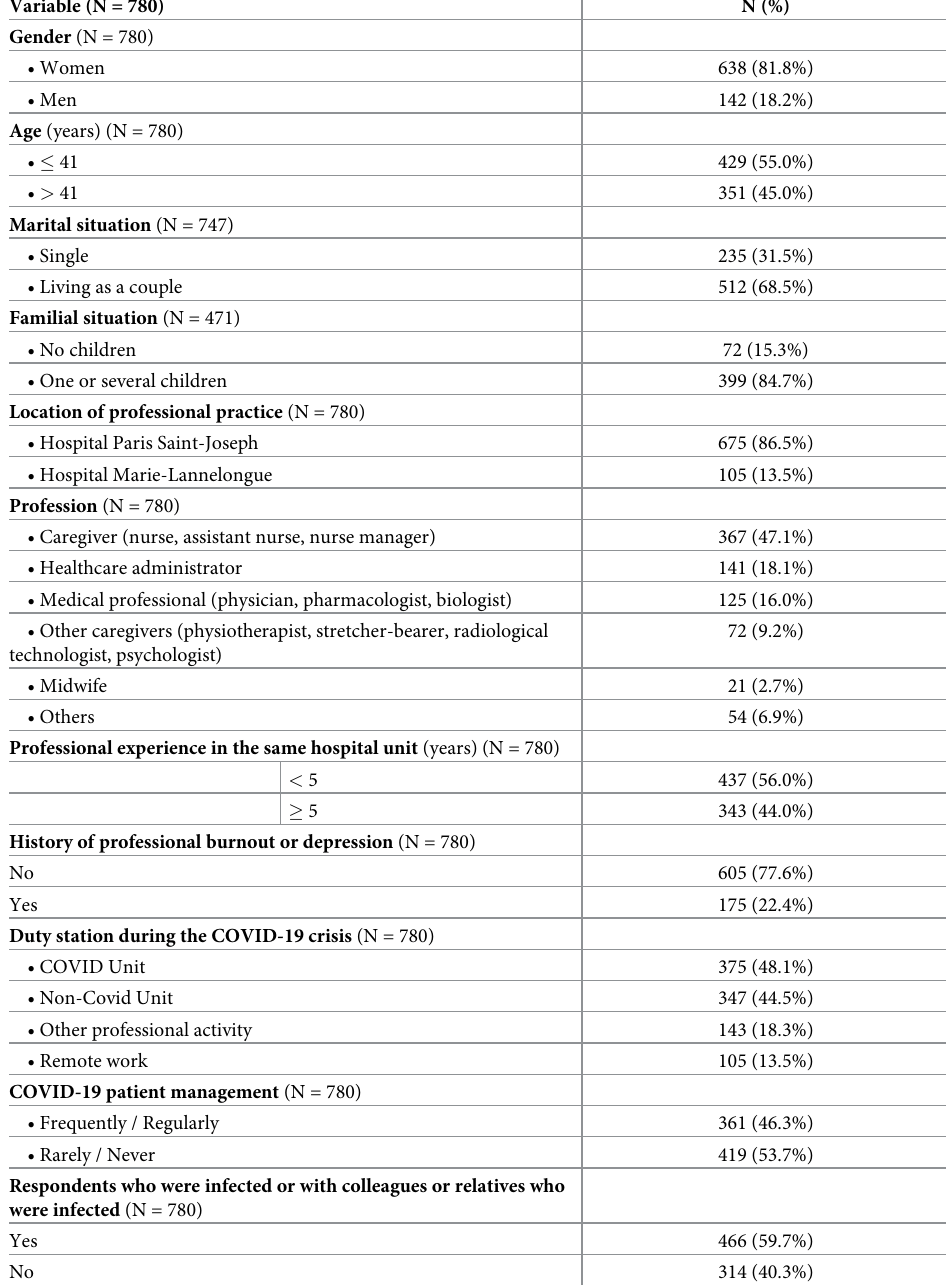
Table 1. Respondents’ characteristics and reports about their COVID-19